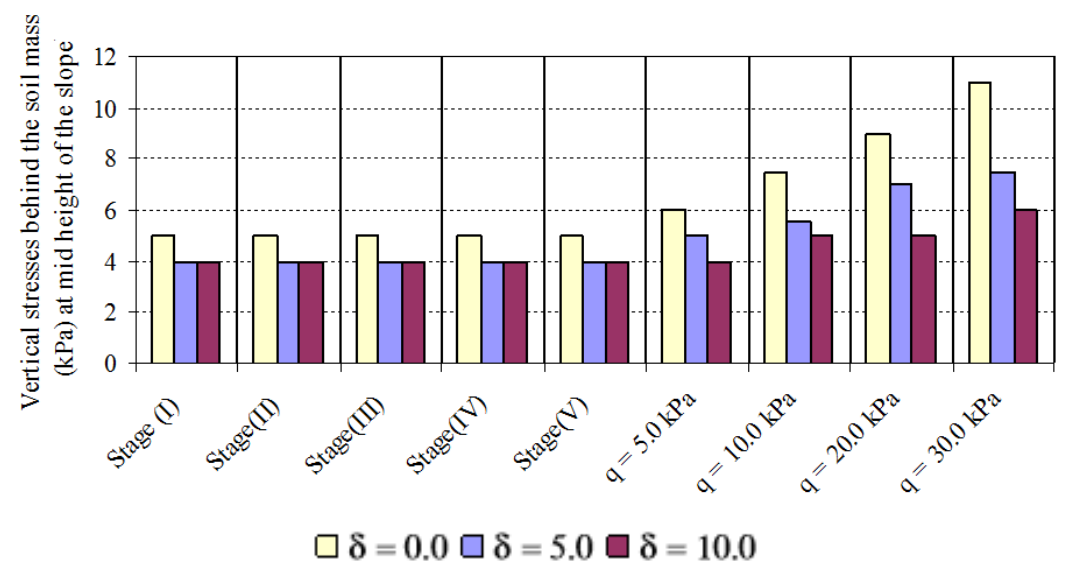
Figure 21. Influence of nail inclination on vertical stresses behind the nailed soil mass at mid height of slope.